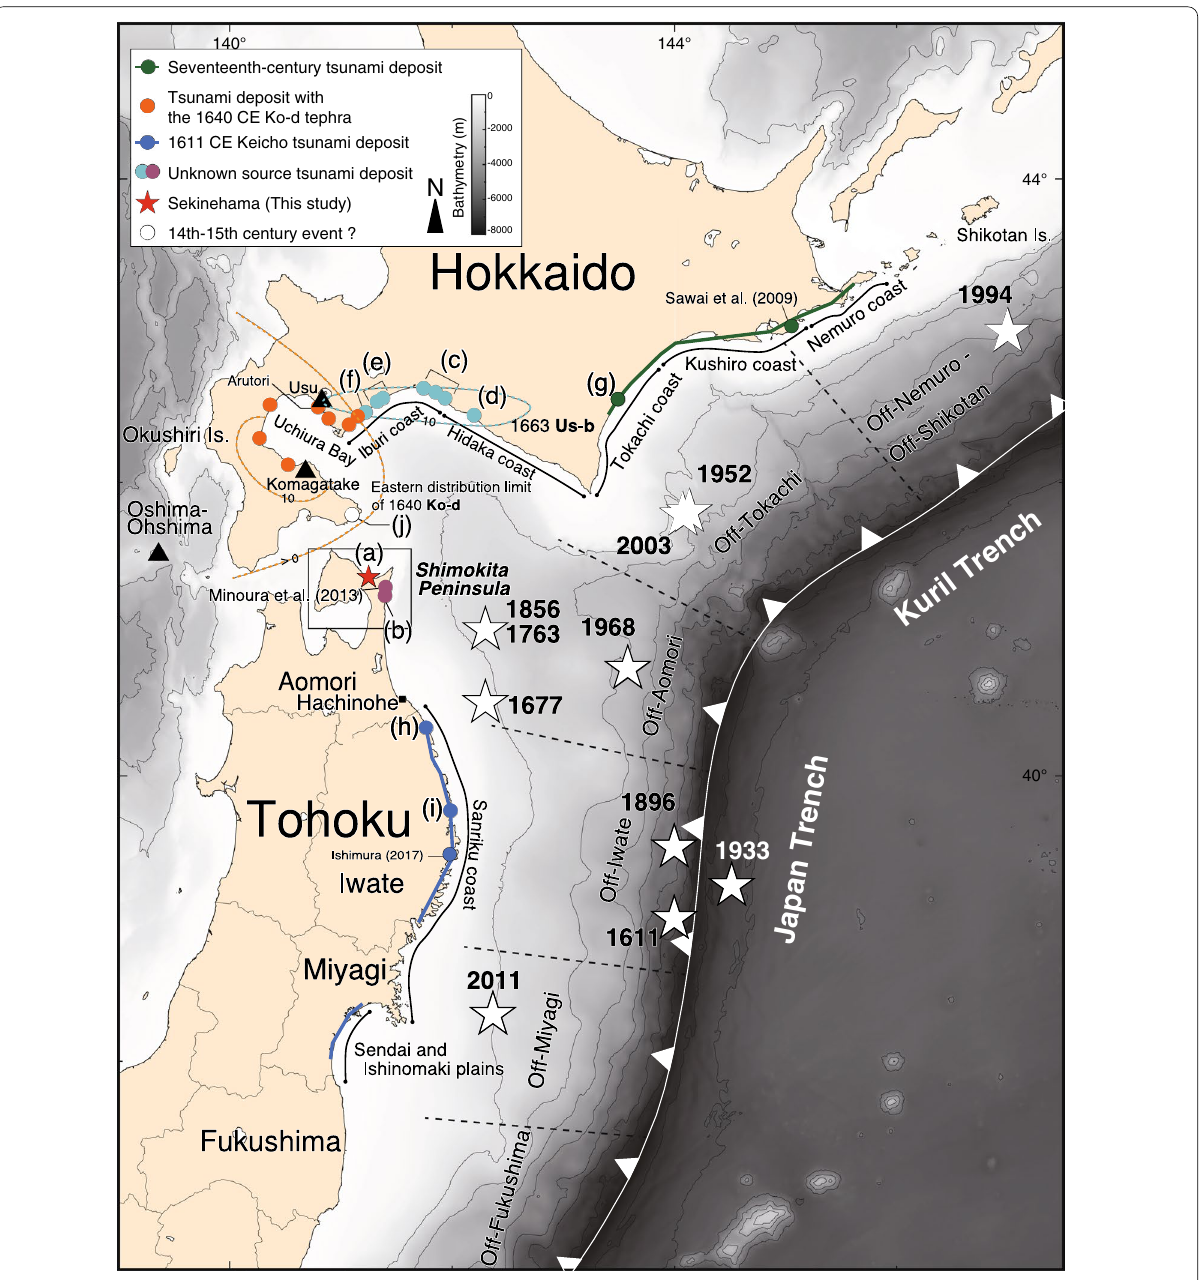
Fig. 1 Distribution map of the tsunami deposits around the seventeenth century along Kuril and Japan Trenches. The lettered color stars and circles indicate the locations of the tsunami deposits included in this study: a Sekinehama (Ishimura et al. 2022), b Odanosawa (Tanigawa et al. 2014), c Yufutsu–Atsuma–Mukawa (Takashimizu et al. 2007), d Kabari (Takashimizu et al. 2017), e Shiraoi (Nakanishi et al. 2014), f Kojohama (Nakanishi and Okamura 2019), g Oikamanai (Nanayama et al. 2002), h Harashinai (Takada et al. 2016), i Masaki (Takada et al. 2016), and j Takadai (Kase et al. 2022). The black frame indicates the Shimokita Peninsula, the white stars show the locations of historical and modern earthquake hypocenters (see Table 1 for detail), and the orange and light blue dashed lines show the thickness distribution of the 1640 CE Ko-d tephra (10 cm and > 0 cm contour lines) and 1633 CE Us-b tephra (10 cm contour line) (Nakamura 2016), respectively. The gray lines are bathymetric contour lines drawn at 1000 m intervals. The grayscale bar indicates bathymetry. The plate boundary was adapted from Iwasaki et al.